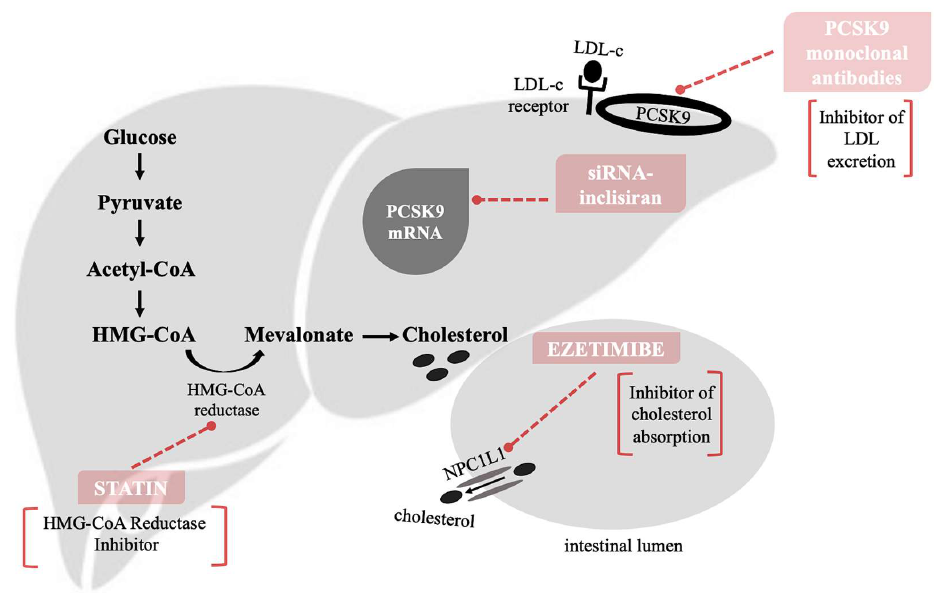
Figure 1. The mechanism by which statins act to reduce liver cholesterol production is based on the competitive inhibition of rate-controlling enzyme in cholesterol synthesis 3-hydroxy-3-methylglu- taryl-CoA (HMG-CoA) reductase. This enzyme catalyzes the conversion of HMG-CoA to a mevalonic acid, a necessary step in the biosynthesis of cholesterol. Ezetimibe inhibits the absorption of cholesterol from small intestine leading to the reduction in intestinal cholesterol transmission to the liver [19,22]. The main mechanism is associated with the inhibition of the Niemann-Pick C1-like 1 (NPC1L1) protein, the key factor of cholesterol absorption. Proprotein convertase subtilisin/kexin type 9 (PCSK9) inhibitors inhibit the binding of PCSK9 with low-density lipoprotein (LDL)-receptors and prevent the degradation of LDL-receptors. The inhibition of PCSK9 is targeting also via small interfering RNA (siRNA) against PCSK9 synthesis and expression, small molecules, and vaccination against PCSK9.